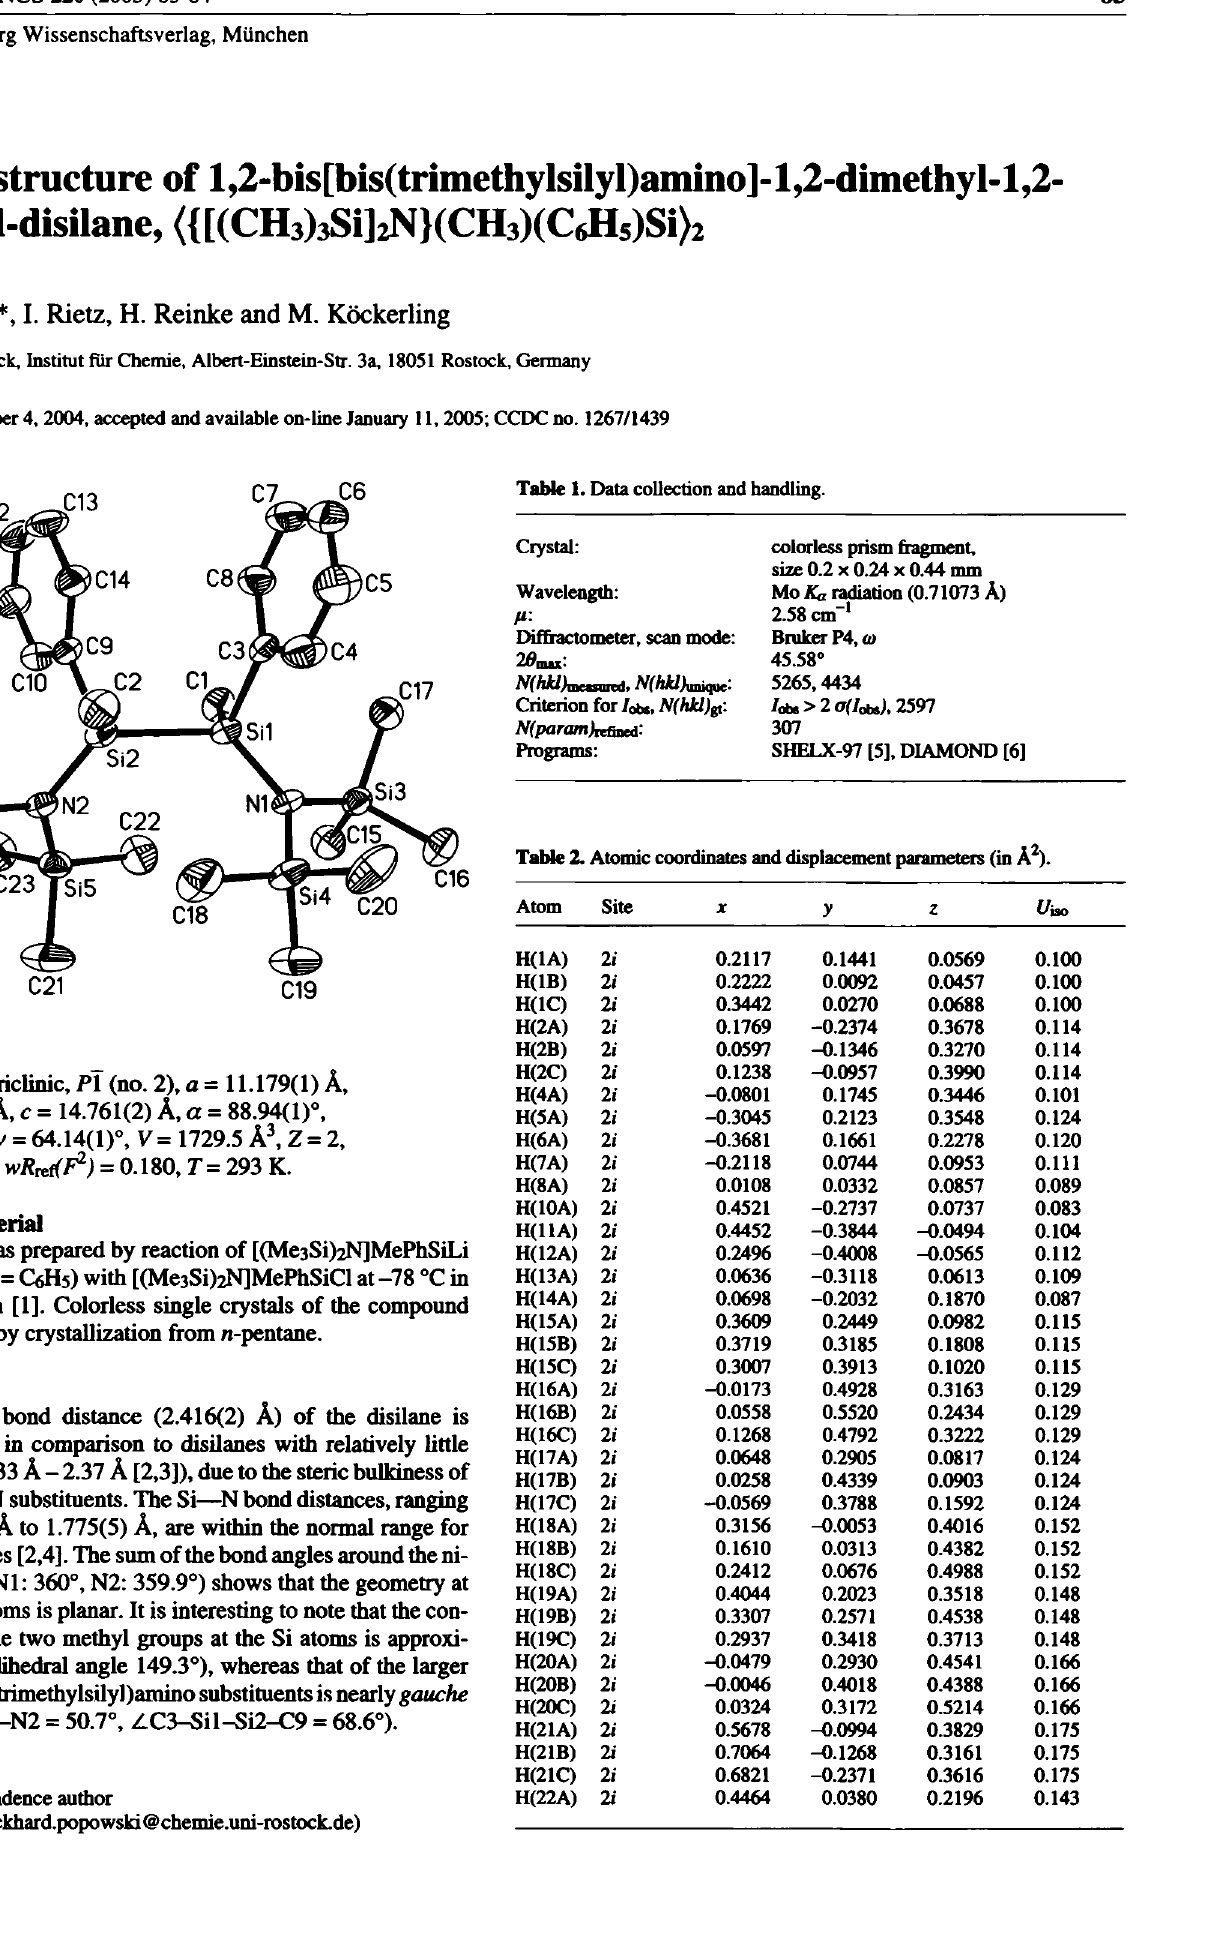
Table 2. Atomic coordinates and displacement parameters (in A 2